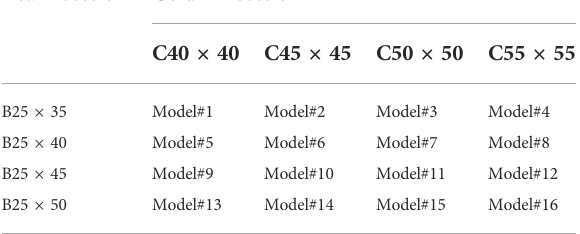
TABLE 2 List of hidden beam models. Beam section Column section